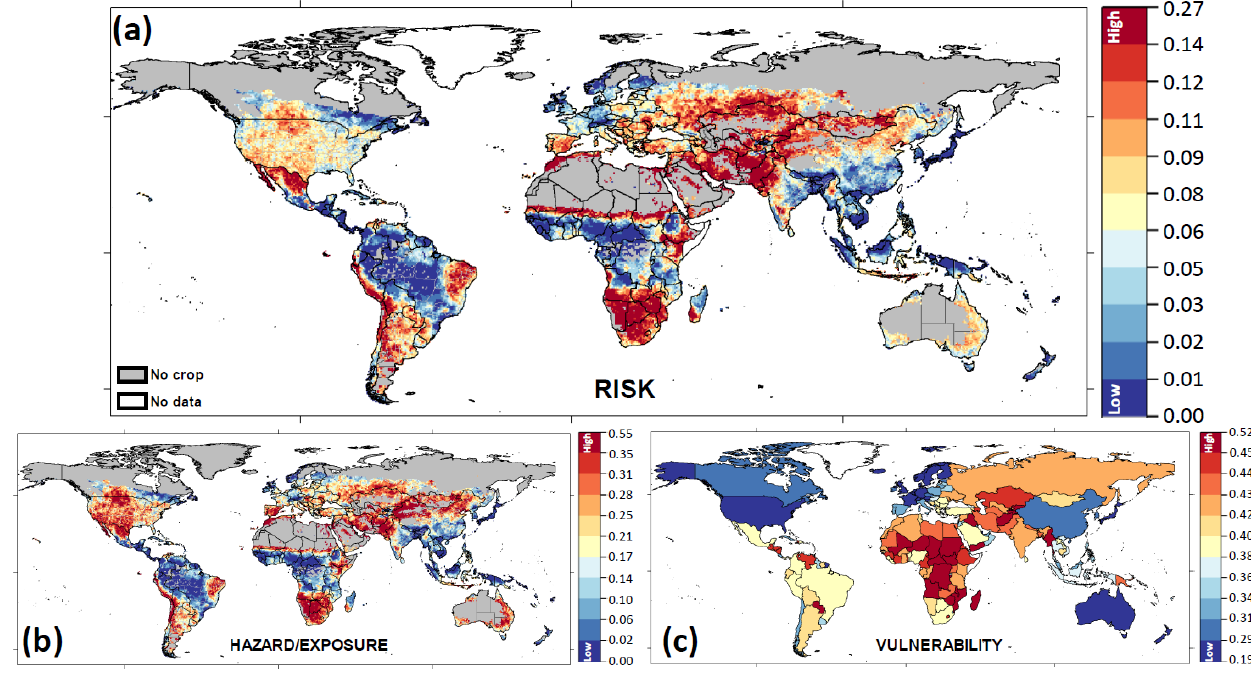
Figure 3. Drought risk (a) , hazard and exposure (b) , and vulnerability (c) for rainfed agricultural systems. The legends were defined by assigning the median of the value distribution to the yellow color in the center, the 90th percentile to the deepest red color and the 10th per- centile to the deepest blue color and by determining the class ranges of the other colors by linear interpolation. Risk was calculated by multiplying hazard and exposure by vulnerability (pixel-level analysis).